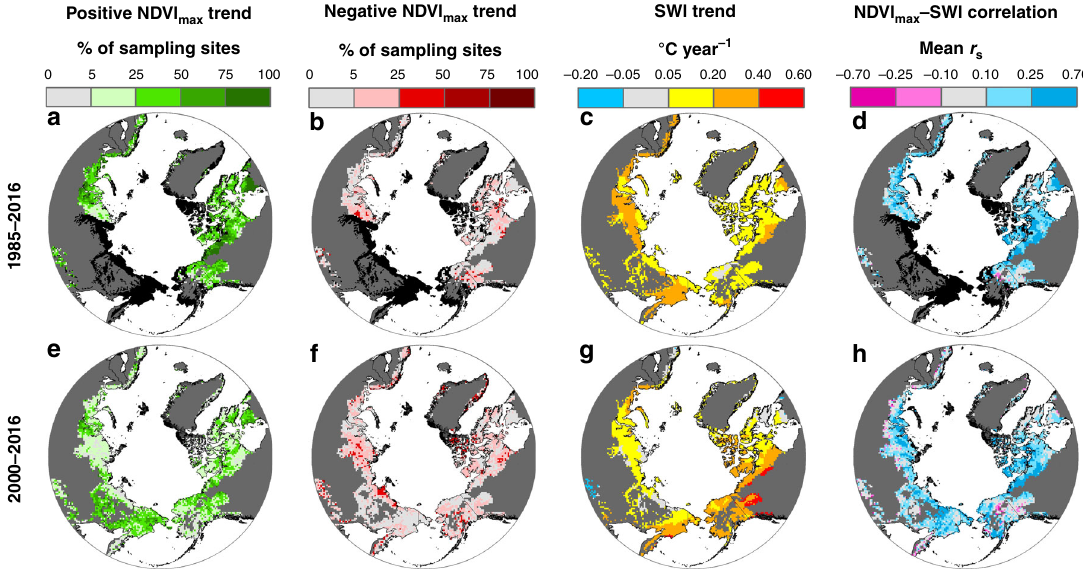
Fig. 4 Tundra greenness and summer air temperature trends and correlations across the Arctic. Top panels ( a – d ) depict Landsat NDVI max trends, summer warmth index (SWI) trends, and NDVI max – SWI correlations from 1985 to 2016, while bottom panels ( e – h ) depict trends and correlations from 2000 to 2016. Trends in tundra greenness were inferred at random sampling sites (Fig. 1b, c) using NDVI max time series and Mann – Kendall trend tests. The percent of sites with positive ( a , e ) and negative ( b , f ) trends [ α = 0.10] was summarized within 50 × 50 km 2 grid cells. c , g Changes in annual SWI derived using an ensemble of fi ve temperature data sets. d , h Mean Spearman ’ s correlation ( r s ) between annual NDVI max and SWI among sites within each 50 × 50 km 2 grid cell. The maps also depict areas in the Arctic that are barren [mean NDVI max < 0.10; dark gray] or lacked adequate Landsat data for trend and correlation assessments